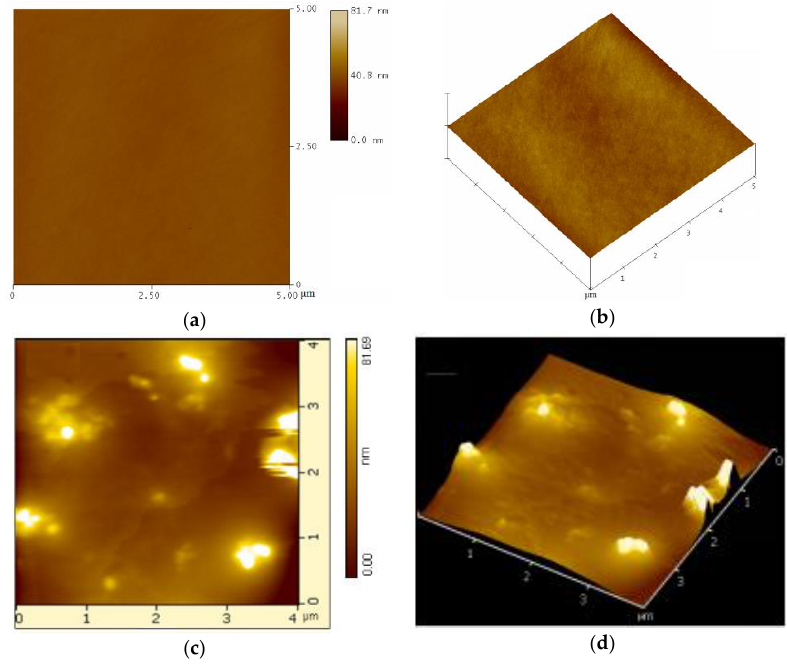
Figure 6. AFM images of FVPS and FSi@SiO 2 coating on a silicon wafer: ( a ) flattened, FVPS; ( b ) 3D, FVPS; ( c ) flattened, FSi@SiO 2 ; and ( d ) 3D, FSi@SiO 2 .